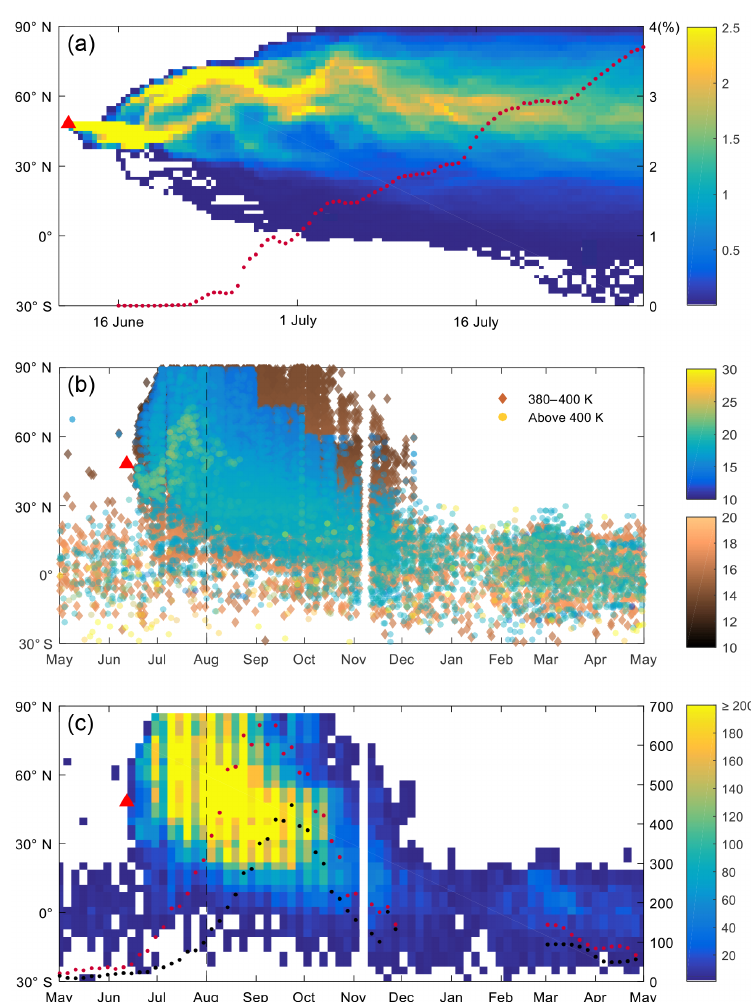
Figure 5. (a) Percentage (%) of air parcels above the 380K isentropic surface from MPTRAC simulations, binned every 12h and 2 ◦ in latitude. Red dots denote the percentage of air parcels above the 380K isentropic surface between 30 ◦ N and 30 ◦ S. (b) Altitudes (km) of MIPAS aerosol detections above the 380K isentropic surface from May 2009 to April 2010. (c) Number of MIPAS aerosol detections above the 380K isentropic surface from May 2009 to April 2010. Detections are binned every 5 days and 5 ◦ in latitude. Red dots denote the number of MIPAS aerosol detections above the 380K isentropic surface between 30 ◦ N and 30 ◦ S. Black dots denote the number of MIPAS aerosol detections above the 400K isentropic surface between 30 ◦ N and 30 ◦ S. The number during the MIPAS data gap in 2009–2010 winter (December, January, and February) is omitted. The red triangle denotes the time and latitude of the first Sarychev eruption. Dashed lines in (b, c) indicate the time corresponding to the end of the MPTRAC simulation in (a) , i.e., 31 July